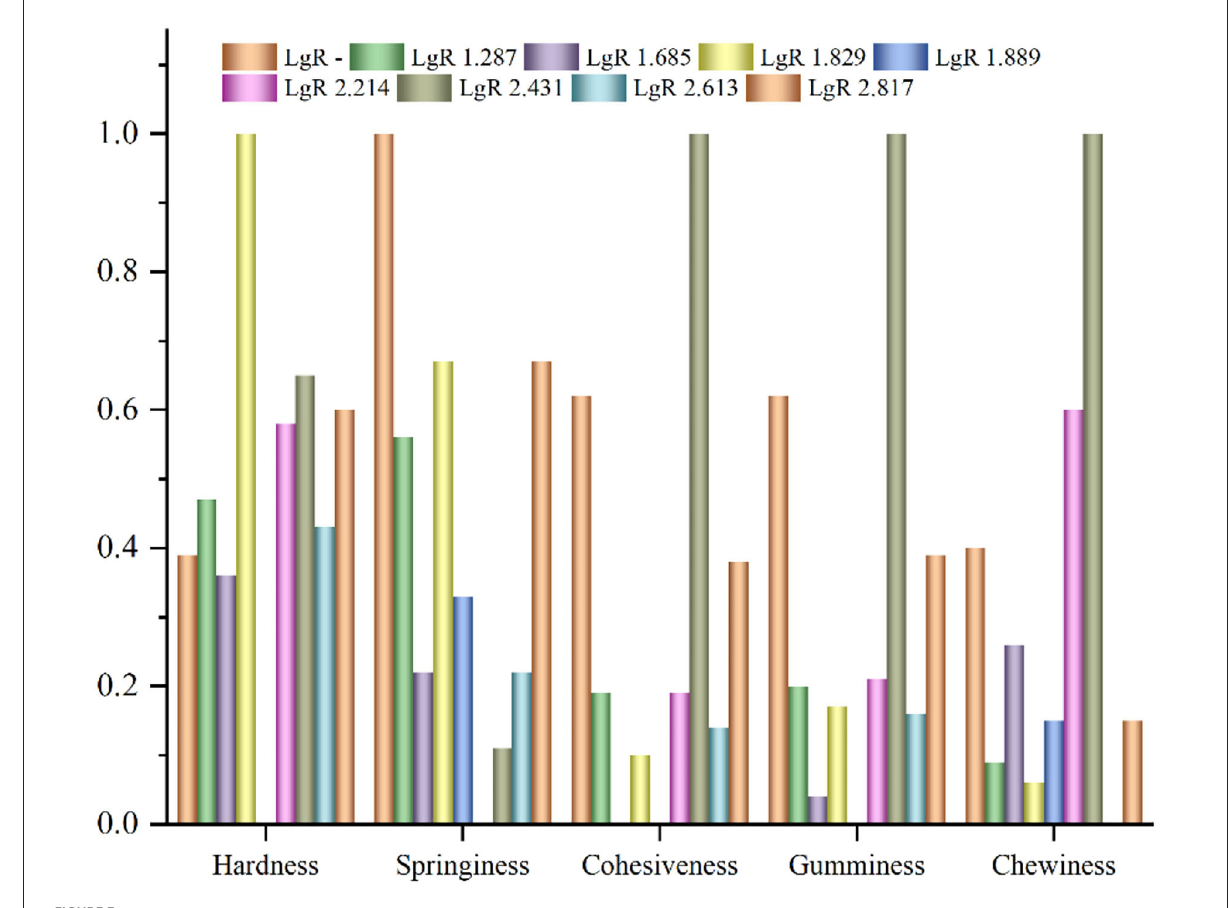
FIGURE3 Textural property of soybean meal. LgR indicates the steam explosion